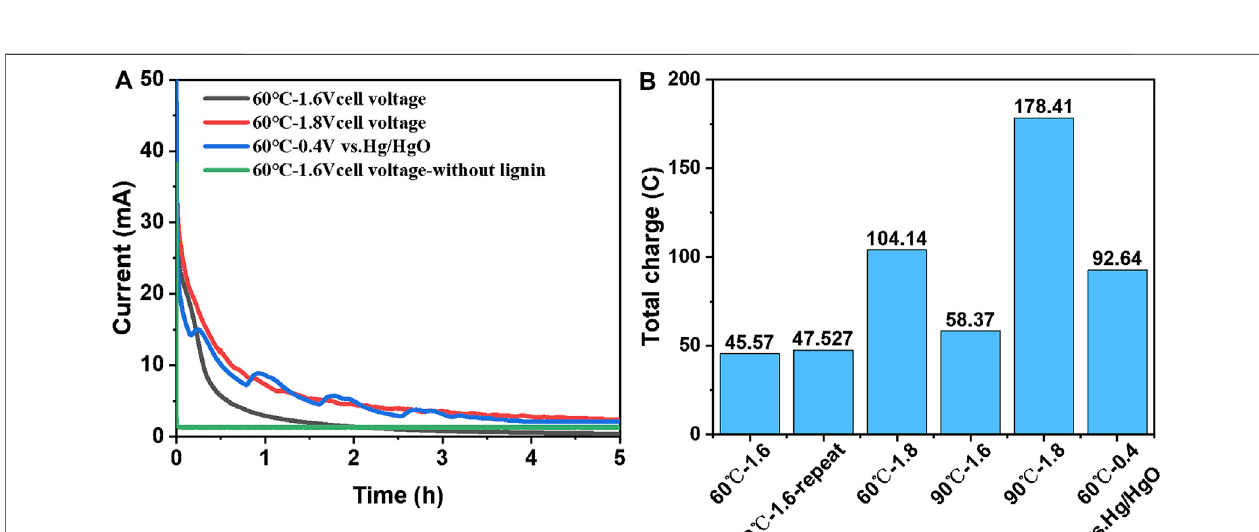
Frontiers in Energy Research |